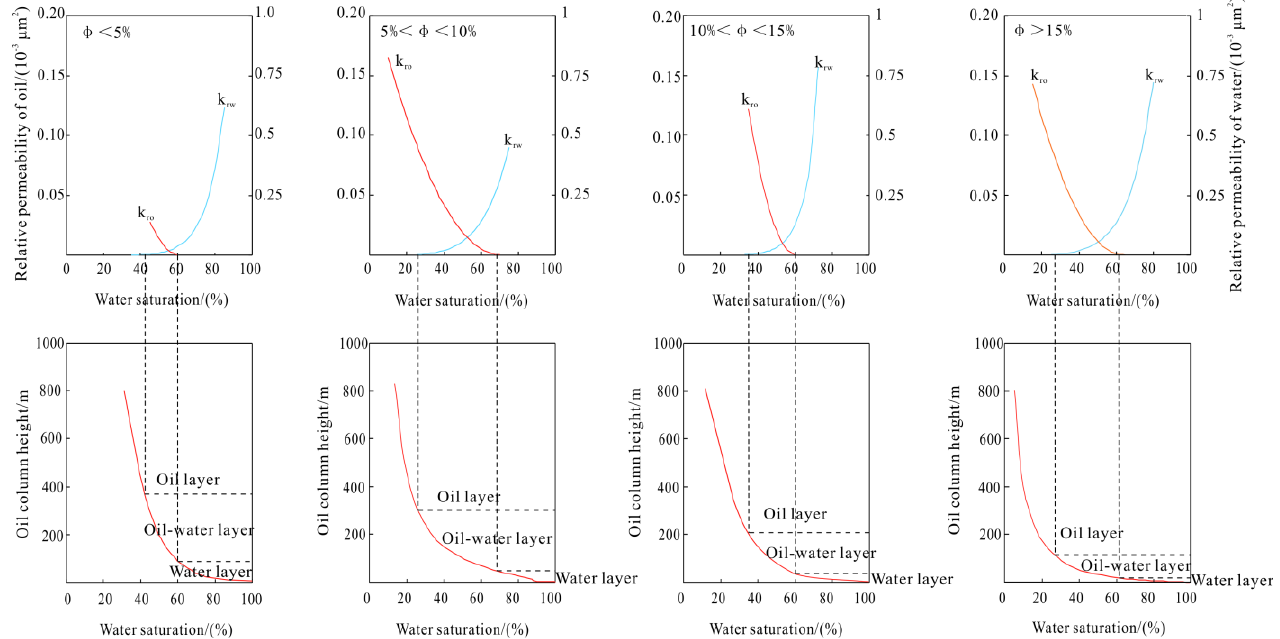
Figure 9. Correlation between reservoir physical properties and oil column heights of the Carboniferous reservoir in the Chepaizi Uplift.